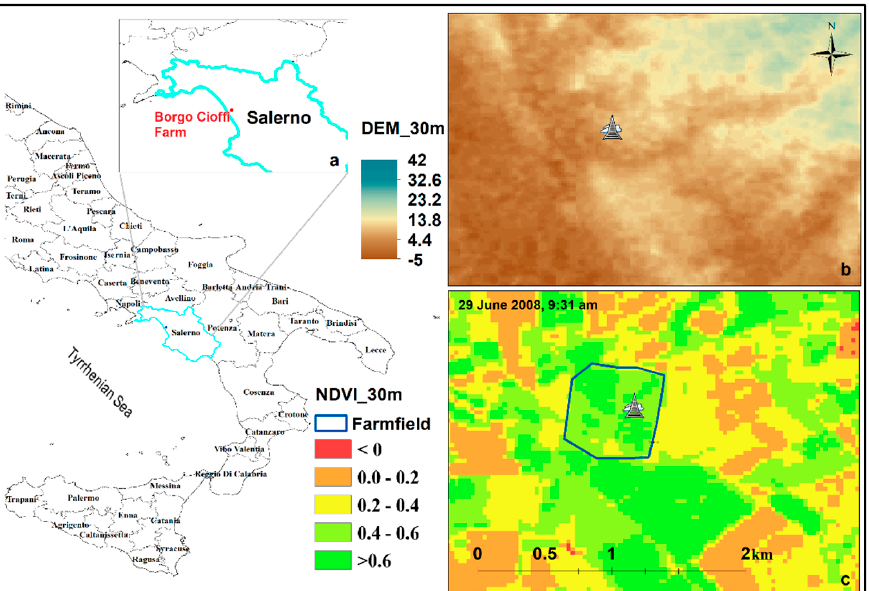
Figure 1. Showing ( a ) location, ( b ) ground elevation, and ( c ) vegetation status of maize rotational crop field lying in Southern Italy near the Tyrrhenian Sea at 5 m elevation